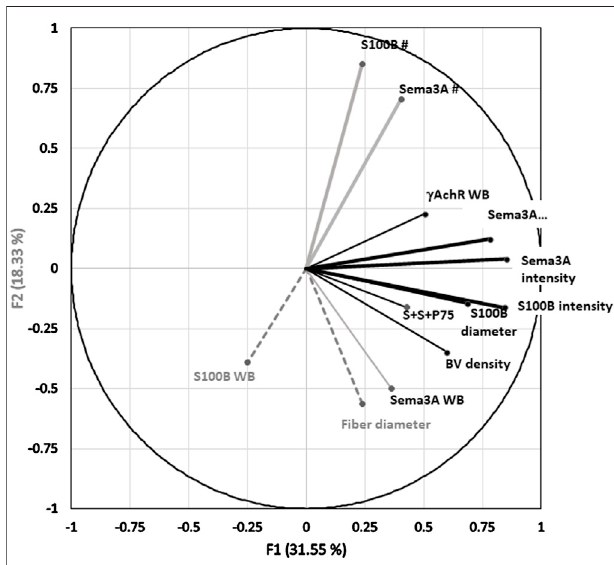
FIGURE 6 | Principal component analysis (PCA) correlation circle of the overall dataset. Two factors or principal components (F1, F2) form the x and y